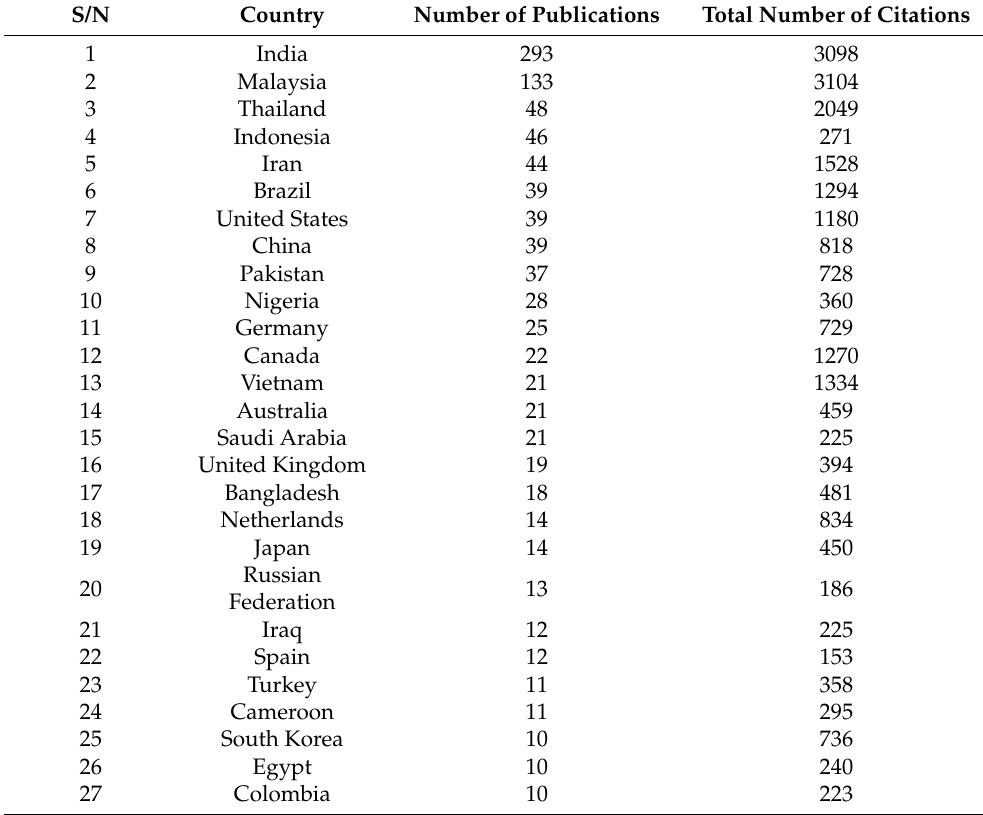
Table 5. Leading countries based on published documents in the present research area until 2021. S/N Country Number of Publications Total Number of